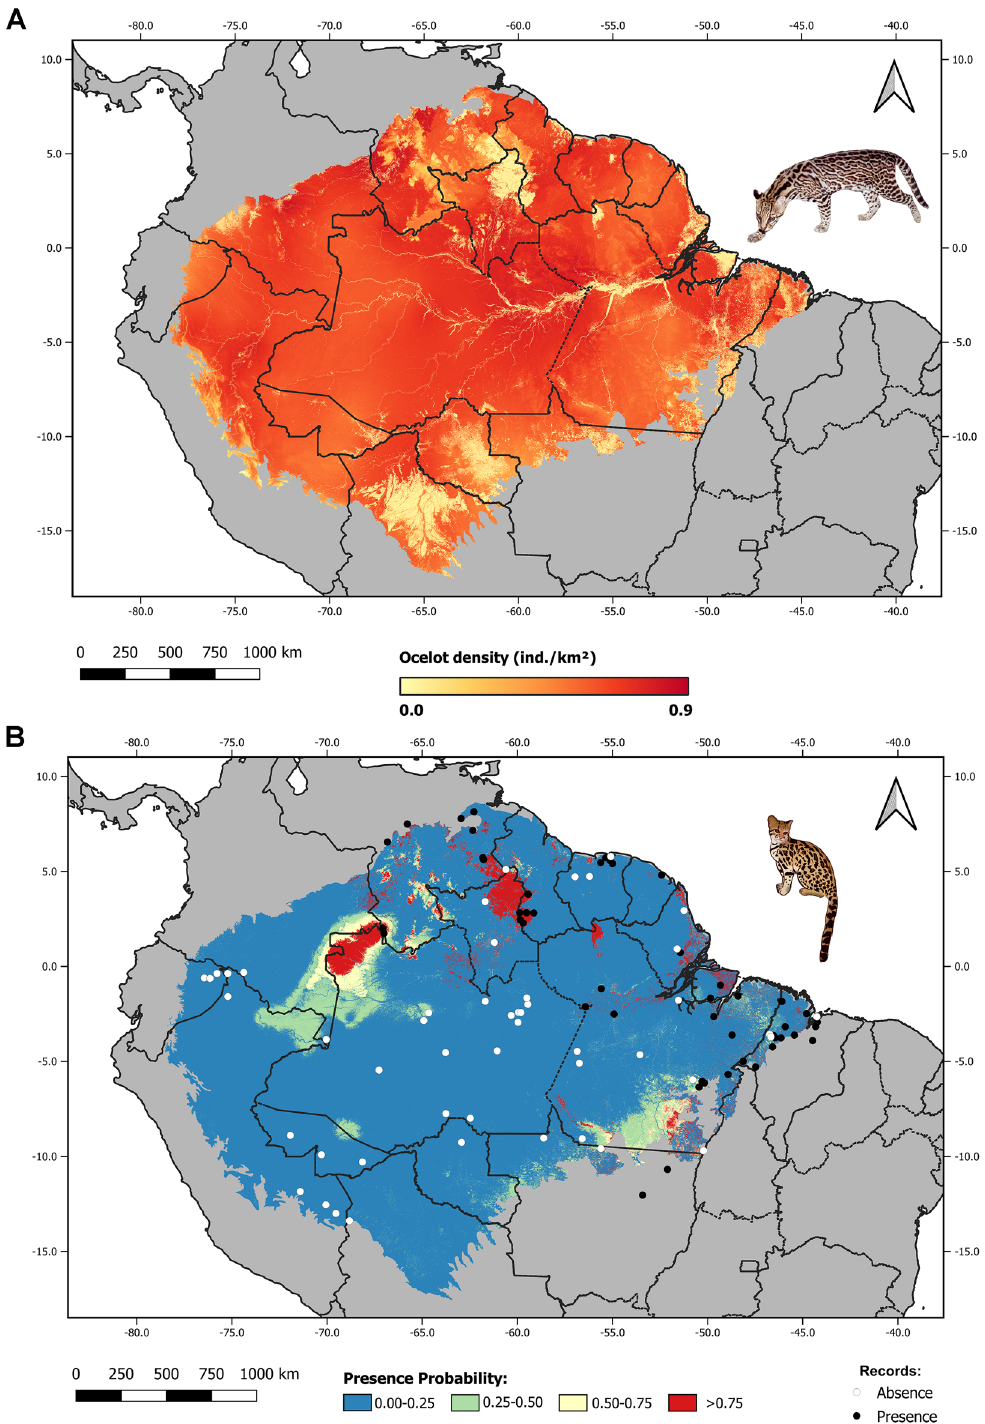
Figure 1. ( A ) Potential ocelot density (ind/km 2 ) in the Amazon biome. ( B ) Predicted probability of northern tiger cat presence in the Amazon biome with presence/absence records. Figure made on QGIS ver. 3.4 (www. qgis.